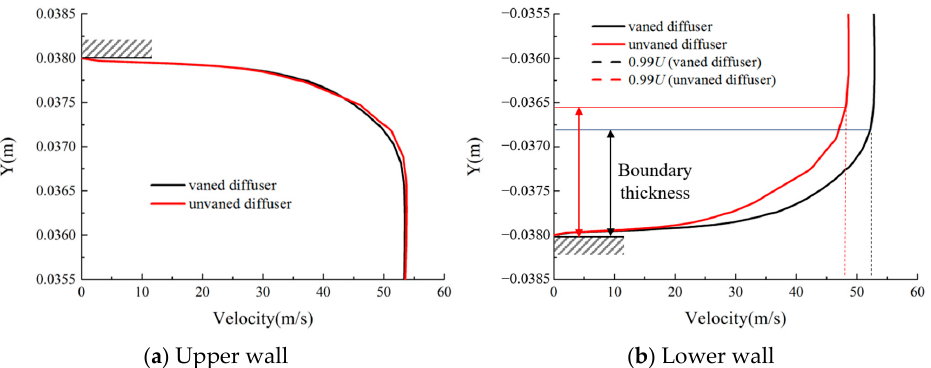
Figure 13. Velocity distributions in the boundary layer at the throat.